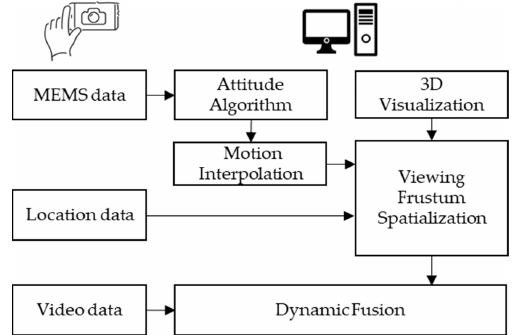
Figure 1. Dynamic fusion flowchart with mobile video as an example.